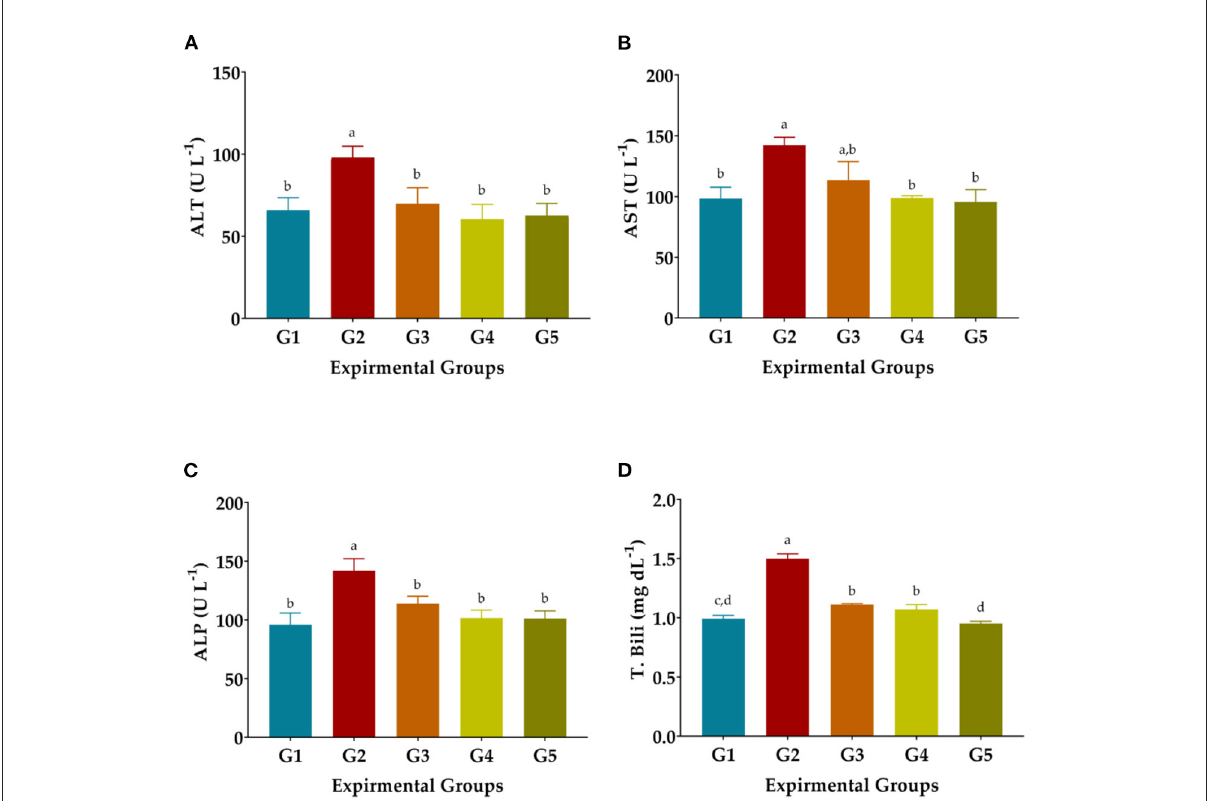
FIGURE1 Effect of hydroalcoholic extract of L. culinaris sprouts on liver’s functions in CCl 4 -induced oxidative stress and hepatotoxicity in rats (mean ± SE), n = 8. (A) ALT: Alanine aminotransferase. (B) AST, Aspartate Aminotransferase. (C) ALP, Alkaline phosphatase. (D) T. Bili, Total bilirubin, a,b,c,d : Bars not sharing similar letters are statistically different at p <